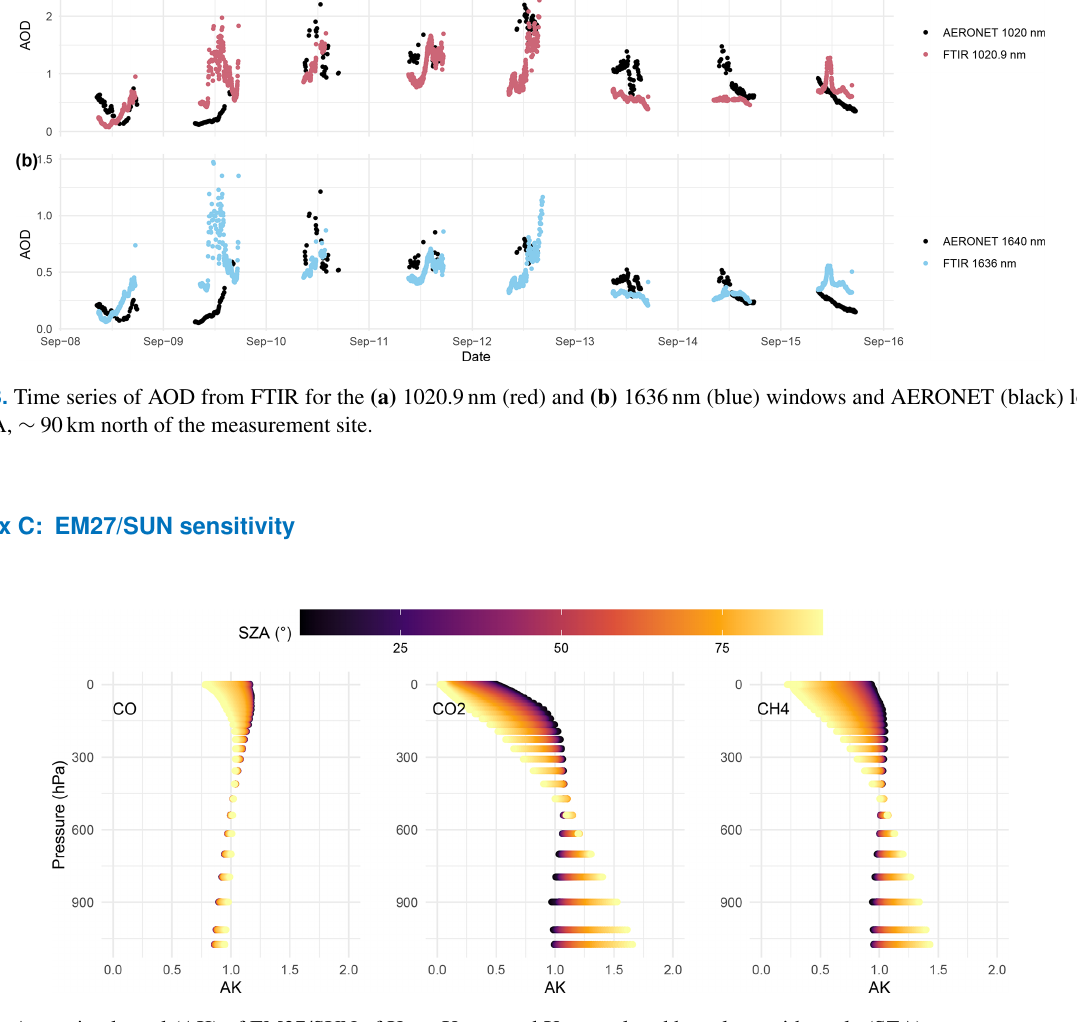
Figure C1. Averaging kernel (AK) of EM27/SUN of X CO , X CO The EM27/SUN has different instrument sensitivities that are defined by the averaging kernels (AK) for each species measured (shown in Fig. C1). The difference in sensitivity for the trace gases may introduce a bias in the calculated ERs and MCE. Most of the difference is expected to be at the height of the plume where the smoke is concentrated